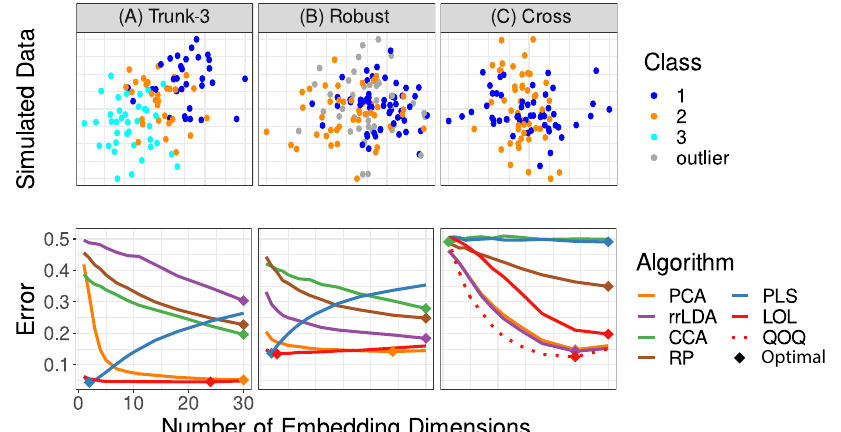
Fig. 1 Three simulations demonstrating the fl exibility and accuracy of XOX in settings beyond current theorical claims. For all cases, training sample size and dimensionality were both 100. The top row depicts the values of the sampled points for two of the 100 dimensions to illustrate the classi fi cation task. The bottom row misclassi fi cation rate as a function of the number of projected dimensions, for several different embedding approaches. Classi fi cation is performed on the embedded data using the LDA classi fi er for ( A ) and ( B ), and using QDA for ( C ). The simulation settings are: A Trunk-3 A variation of Fig. 5b in which three classes are present. B Robust Outliers are prominent in the sample while estimating the projection matrix. LOL is robust to the outliers due to the robust estimate of the fi rst moment. C Cross The two classes have the same mean but orthogonal covariances. Points are classi fi ed using the QDA classi fi er after projection. QOQ , a variant of LOL where each class' covariance is incorporated into the projection matrix, outperforms other methods, as expected. In essentially all cases and dimensions, LOL , or the appropriate generalization thereof, outperforms other